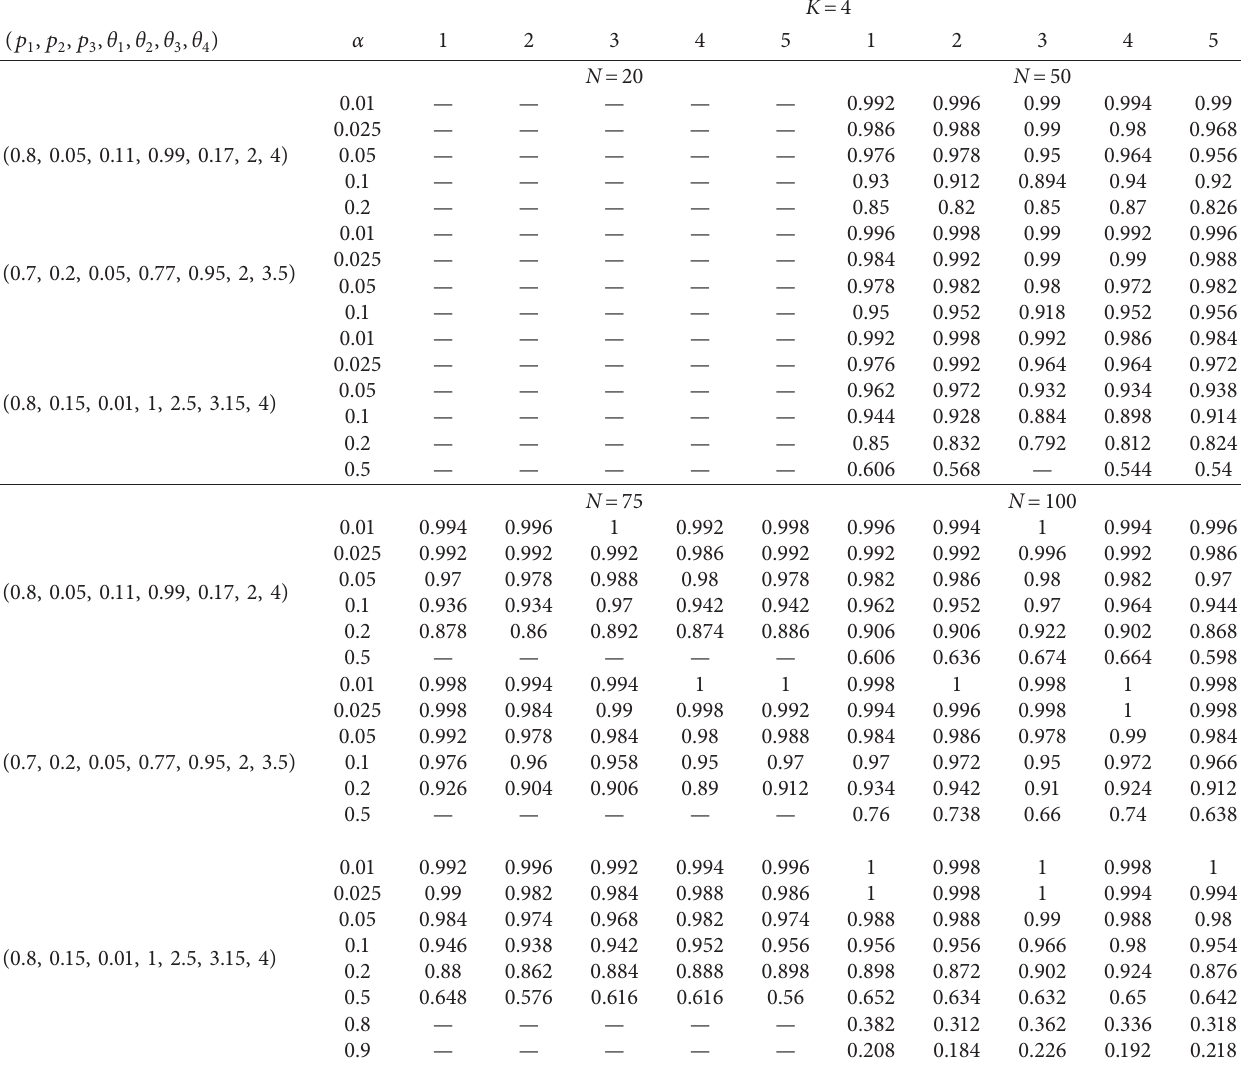
Table 6: Power results for estimated number of finite exponential components at k �